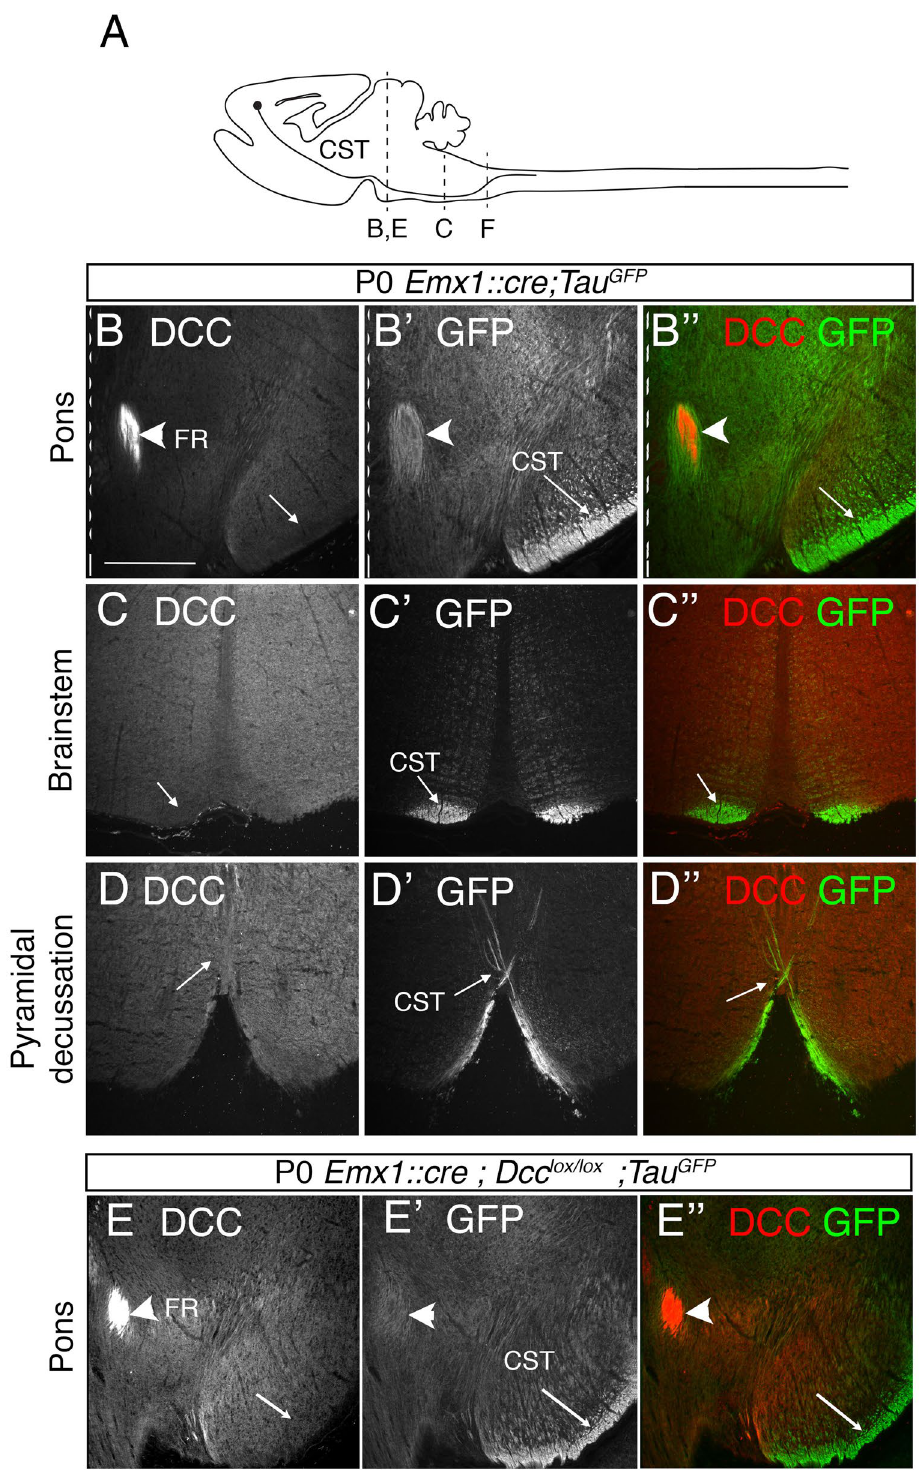
Figure 6. DCC is not detected in CST axons when they cross the midline. ( A ) Schematic representation of a P0 mouse sagittal section indicating the trajectory of the CST and the level of the coronal sections presented in this figure. Coronal sections of P0 Emx1 :: cre ; Tau GFP mice (n = 3, B , C , D ) and of P0 Emx1 :: cre ; Dcc lox / lox ; Tau GFP mice (n = 3, E ) stained with anti-DCC ( B–E ), anti-GFP (B’–E’), and both labels (B”–E”). GFP staining was used as a marker of corticospinal tract axons. DCC was not detected at the CST in the pons ( B,E ), brainstem ( D ) or pyramidal decussation ( F ). DCC was expressed in the fasciculus retroflexus (FR, B , E ), used as a positive control. Dashed lines indicate the midline. The scale bar represents 184 μ